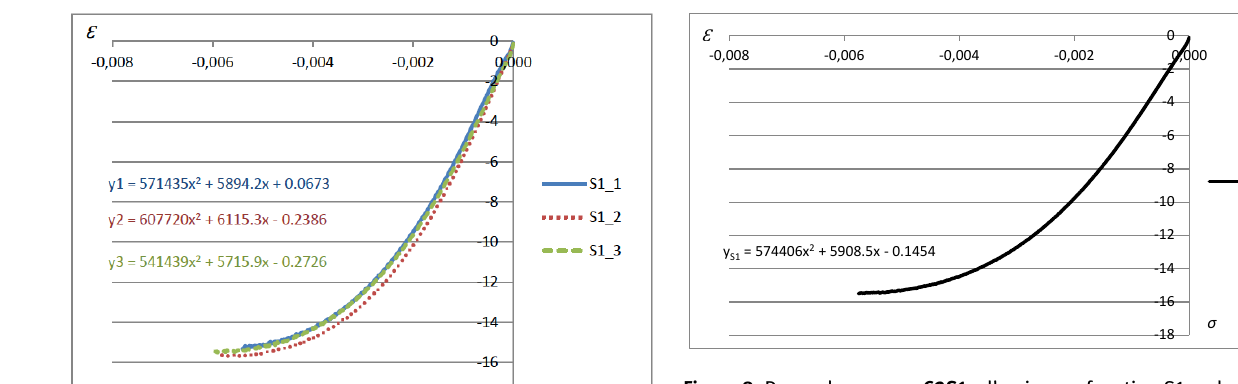
Figure 8: Dependence σ on C2S1 adhesive, as function S1 under compression